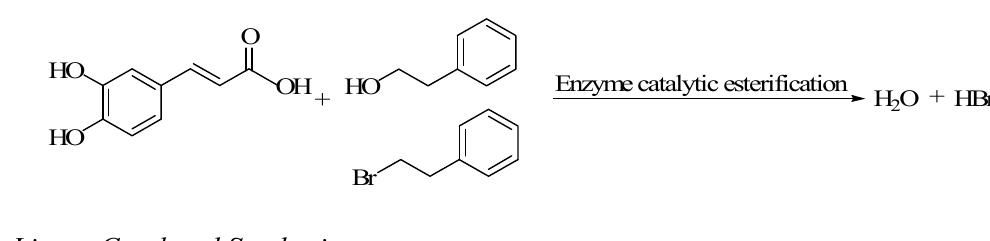
Figure 11. The reaction of enzyme catalytic